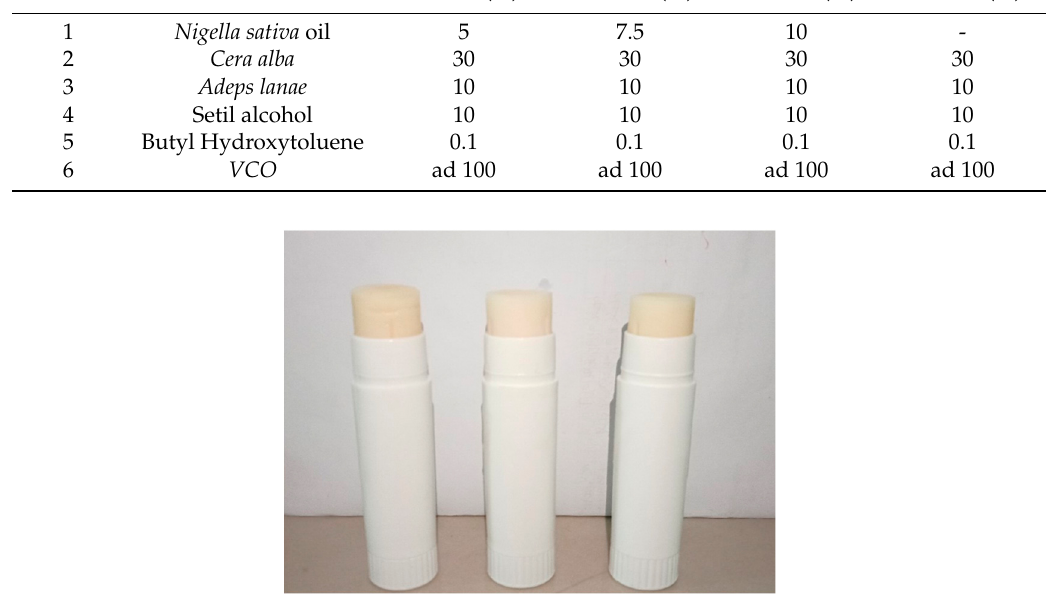
Figure 1. Nigella sativa Balm Stick .